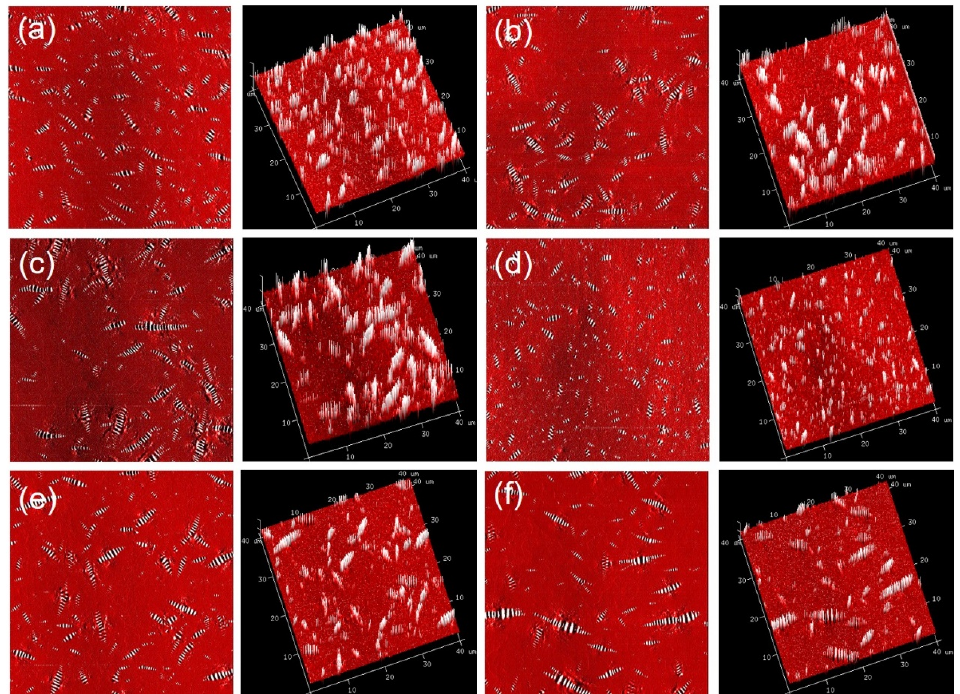
Figure 7. Microstructure and 3D structural side view of the asphalt binder imaged using atomic force microscopy (AFM): ( a ) virgin asphalt, VA; virgin asphalt after ( b ) 12 h and ( c ) 26 h thermal aging, denoted by A12h and A26h, respectively; ( d ) hard asphalt mixed with ( e ) 12 h and ( f ) 26 h aged virgin asphalt, denoted by A12h + HA and A26h + HA, respectively.